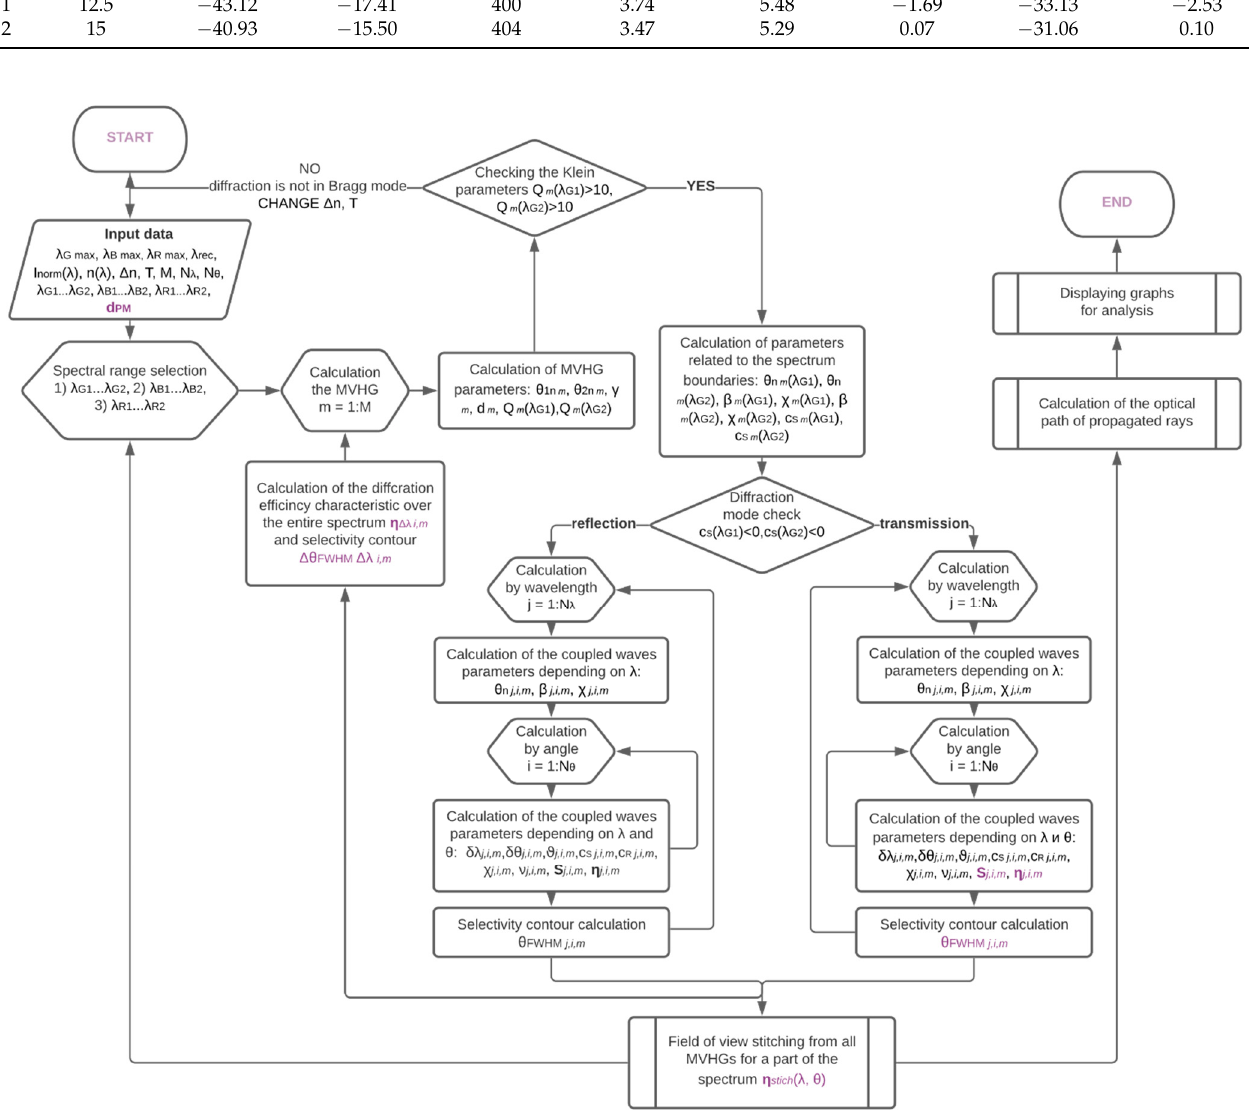
Figure A1. Flow chart of mathematical modeling for MVHGs based on coupled wave theory.